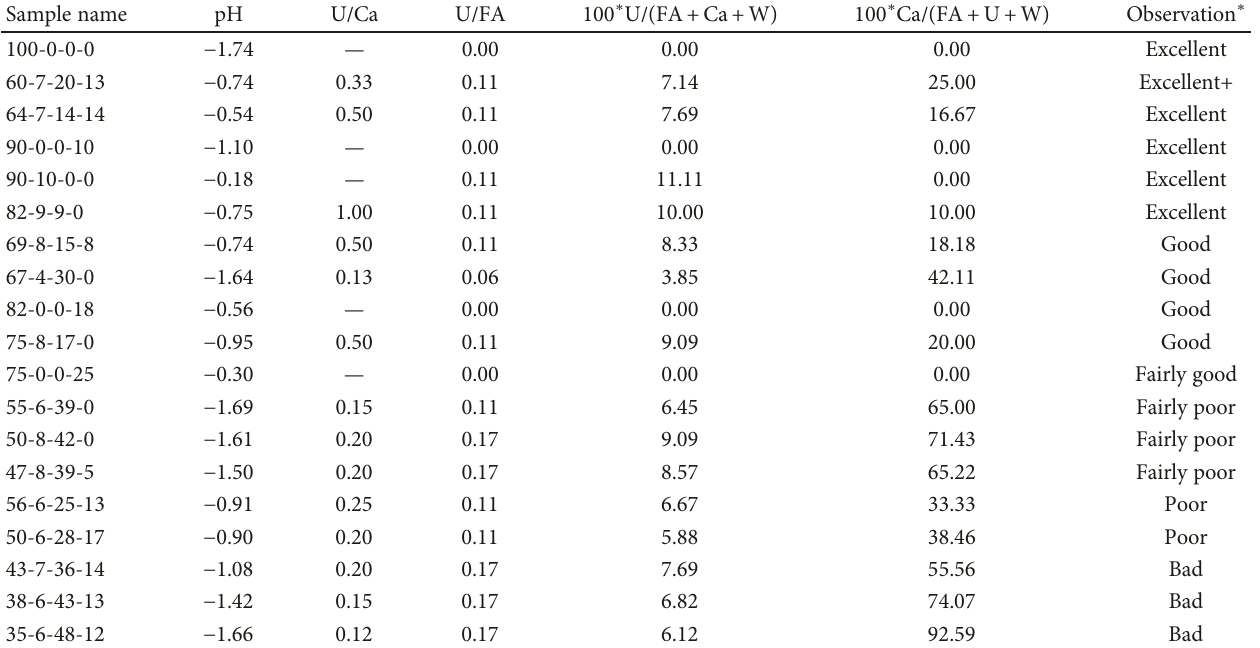
Table 2: Values for the pH and the relative components and also the